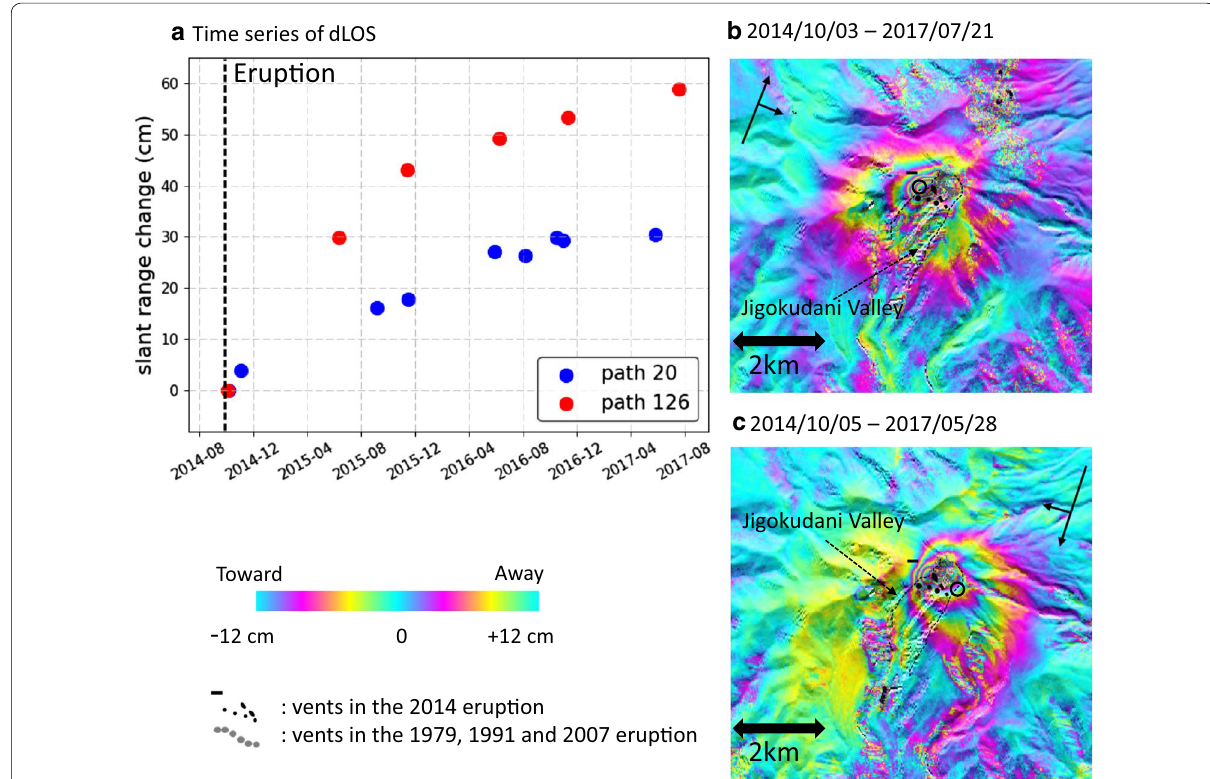
Fig. 2 a Time series of slant range change at pixels of most deformed area. These pixels are indicated as black circles in b and c . The time plots were obtained from two independent orbits of ALOS-2 satellite (Narita and Murakami 2018); path 126, an orbit of ascending and right-looking (red circles) and path 20, an orbit of descending and right-looking (blue circles), respectively. Stack of interferograms in b path 126 from 2014/10/03